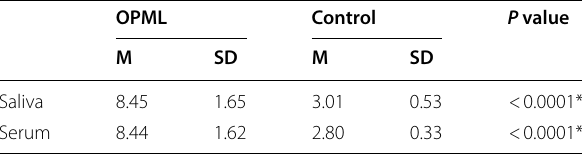
Table 6 Mean and standard deviation of saliva and serum regarding control and OPML and comparison between them